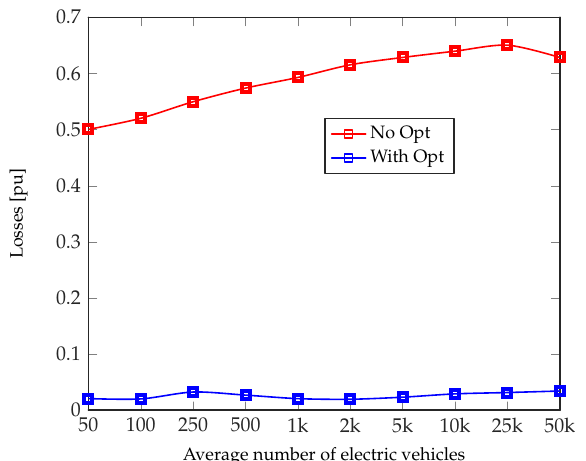
Figure 9. Loss behavior considering optimal HC management in a 33-bus DC distribution